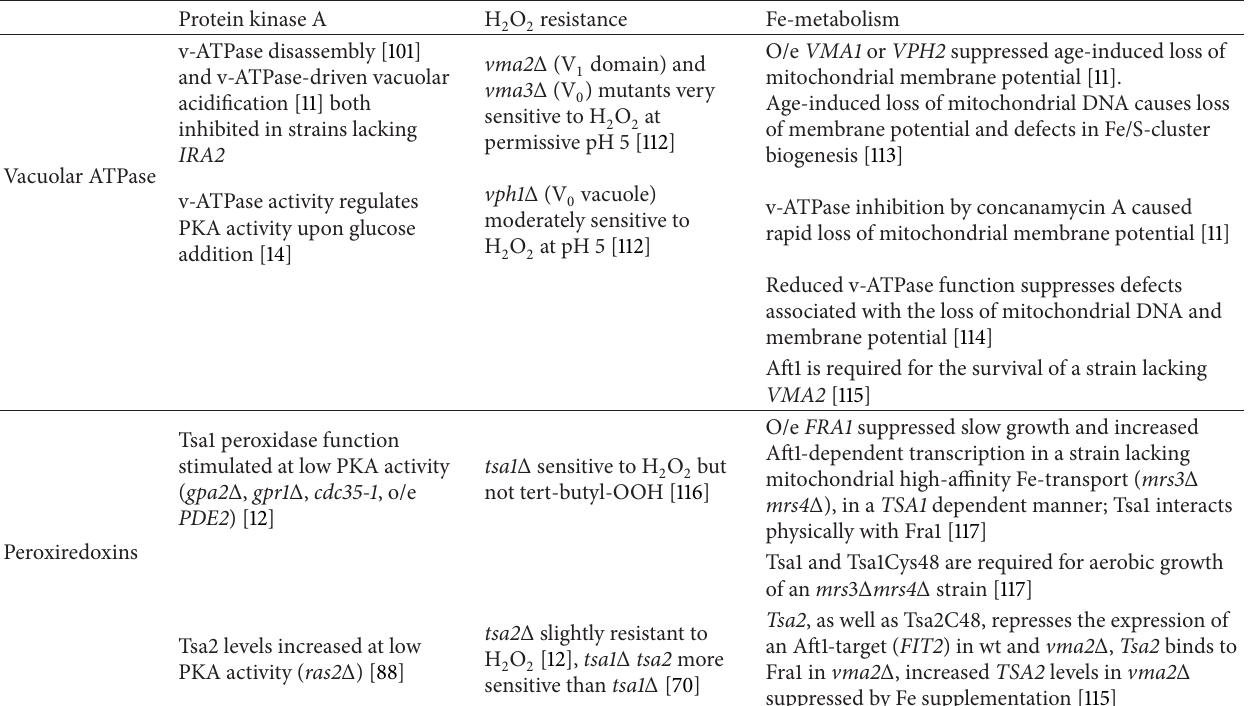
Table 1: Common denominators of v-ATPase and peroxiredoxin functions in yeast which might impinge on calorie-restriction-mediated life span extension. For more details see the text. O/e: overexpression; Fe: iron; Δ : deletion mutant. Protein kinase